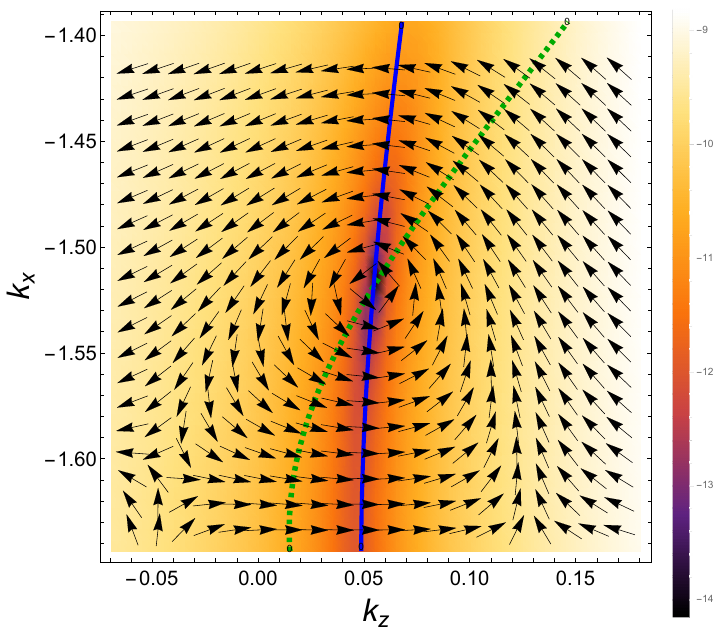
| for electron-impact ionization of hydrogen for a fixed incident Figure 4. A density plot of ln | T CB1 k ,1 s energy of 76.4541 eV in-plane and a grid in the z - and x -components of the momentum ( k z , k x ) of the ] and Im [ T CB1 ] are shown respectively, by the solid blue ejected electron k . The nodal lines of Re [ T CB1 k ,1 s k ,1 s line and the dashed green line. The direction of the velocity field, ˆ v = v / | v | , is indicated by the arrows.